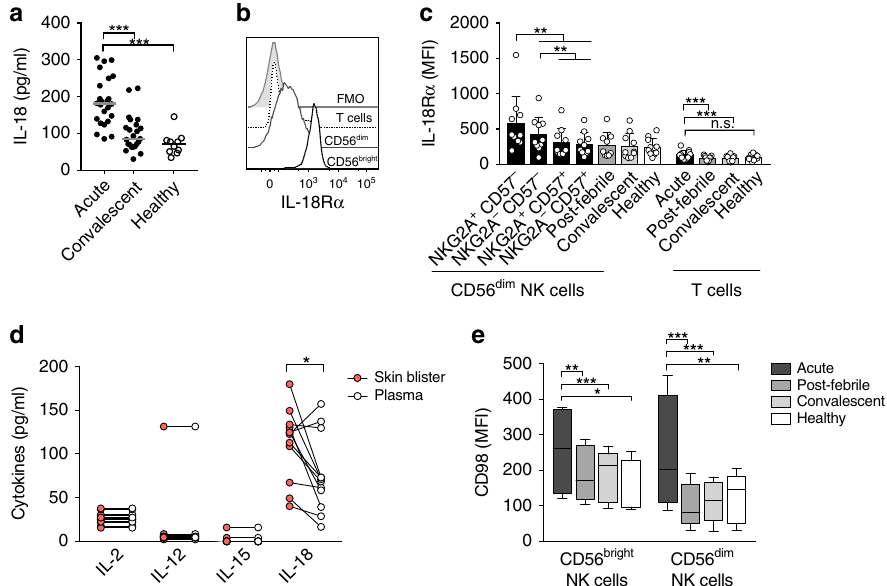
Fig. 4 Increased levels of interleukin-18 (IL-18) during the acute phase of dengue virus (DENV) infection. a Summary of data showing levels of plasma IL-18 (pg/ml) during the acute and convalescent phase of DENV-infected patients ( n = 24) compared to healthy controls ( n = 10). b Representative histograms of IL-18R α expression (mean ± SD) on CD56 bright natural killer (NK) cells, CD56 dim NK cells, and T cells during the acute phase of DENV infection. c Mean IL-18R α expression (median fl uorescence intensity (MFI) on CD56 dim NK cell subsets strati fi ed for NKG2A and CD57 (black bars, left) during the acute phase of DENV infection is shown. These are compared to bulk CD56 dim NK cells from indicated phases (gray and white bars), to T cells from the same stages ( n = 10), and to healthy controls ( n = 11). d Levels of NK cell-activating cytokines from skin blister fl uid collected during the acute phase of DENV infection compared to matched plasma. e CD98 expression (MFI) on NK cell subsets from DENV-infected patients during the acute ( n = 14), post-febrile ( n = 12), and convalescent phase ( n = 14) compared to healthy controls ( n = 15). Lowest and highest observations are displayed with the median indicated as center line. Statistical differences were tested using paired t test or Wilcoxon ’ s matched-pairs signed-rank test. * P < 0.05, ** p < 0.01, and *** p < 0.001. Source data are provided as a Source Data fi